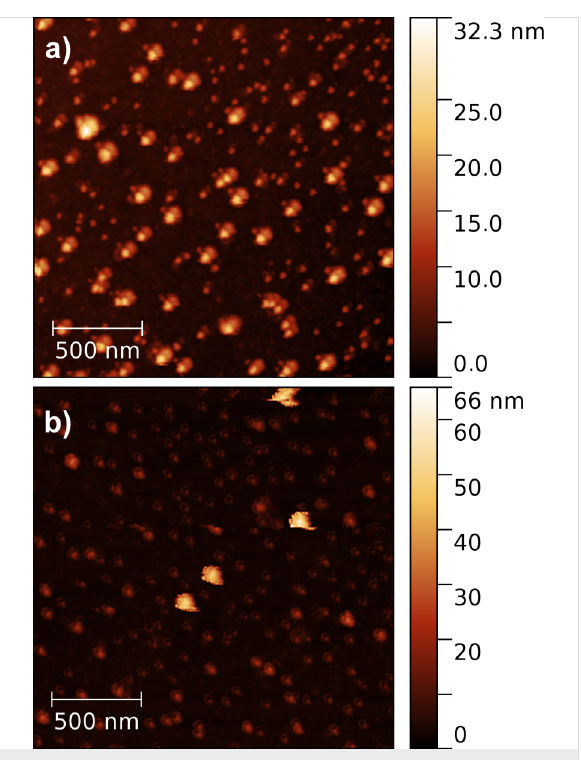
Figure 2: AFM images of a) nanoparticles in C 60 FAS (concentration 0.15 mg/mL) and b) C 60 +Cis mixture (molar ratio as 1:2.4).